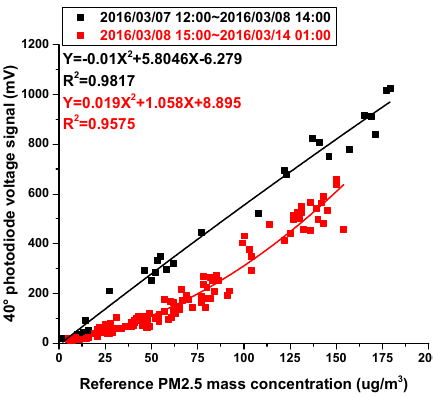
Figure 12. Relationship between PM2.5 mass concentrations measured using the 40° photodiode and reference PM2.5 mass concentrations at Wolongqiao monitoring station.